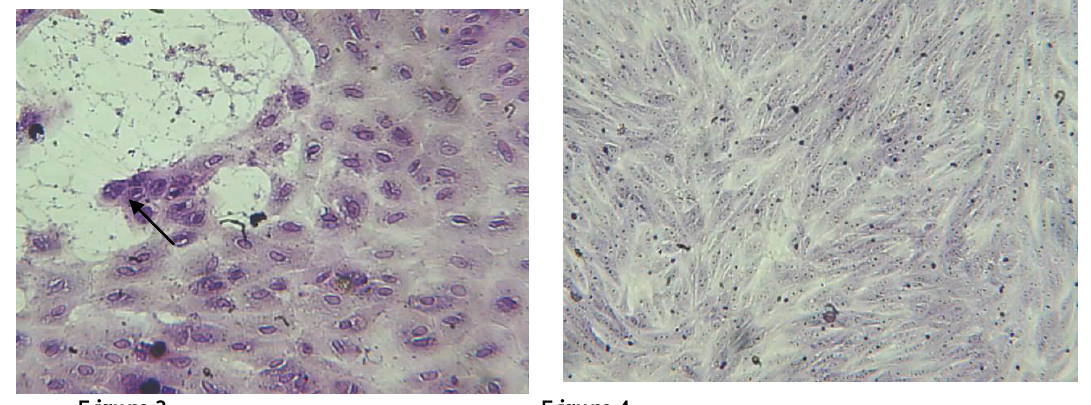
Figure 3 Figure 4 Figure 3: infected SEBK cells with BPIV-3 (8 passages), after 3 days of virus inoculation opaque foci of cells, focal rounding of cells with small and large syncytia formation (→), the syncytia increase in number and size. 100X Figure 4: normal SEBK cell culture100X.